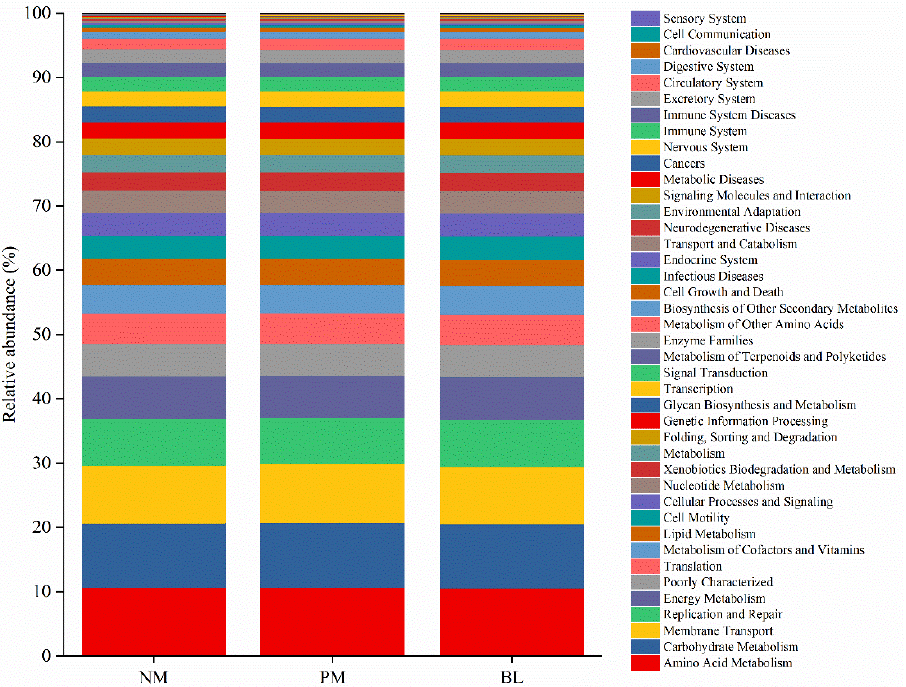
Figure 5. KEGG annotated metabolic pathways of soil bacteria in the three treatments. NM: non- mulched spring maize; BL: bareland fallow; PM: plastic-mulched spring maize. n = 3 (NM, PM, BL).